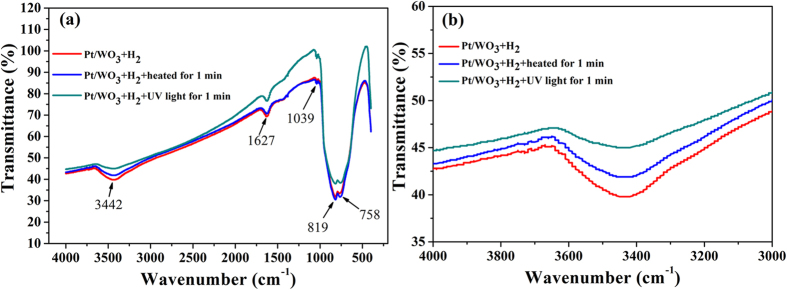
(a) FT-IR spectra of Pt/WO3; (b) Enlargement of peak at 3442 cm−1.